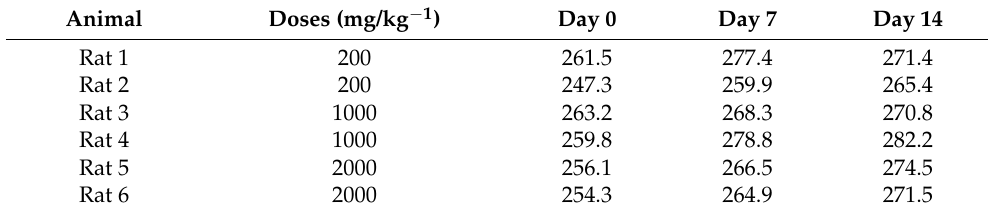
Table 6. Weight of the organs of the animals dermally exposed to the AgNPs.